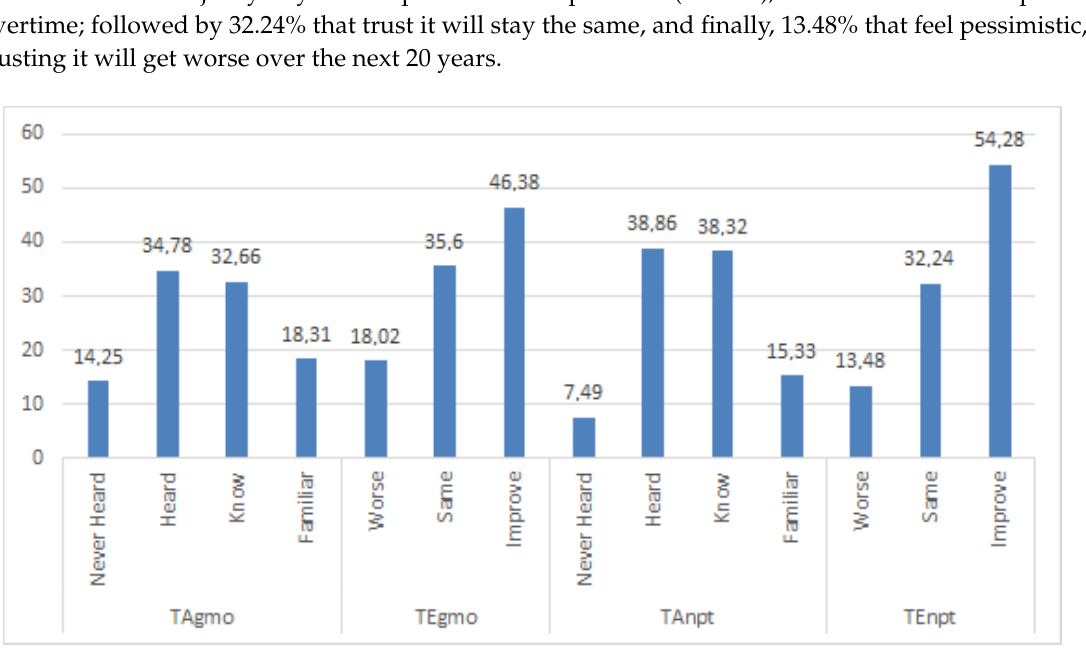
Figure 3. Unconditional percent relative frequencies of youth technological awareness and